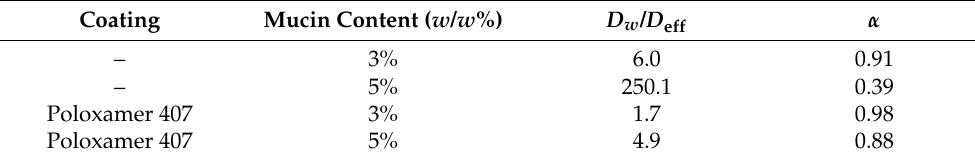
Table 2. Transport characterization of different 100 nm COOH-PS NPs in mucus surrogates containing either 3% or 5% mucin for τ = 1 s. Results are presented as mean ± SD values ( n = 3). Coating Mucin Content ( w / w %) D w / D eff α – 3%